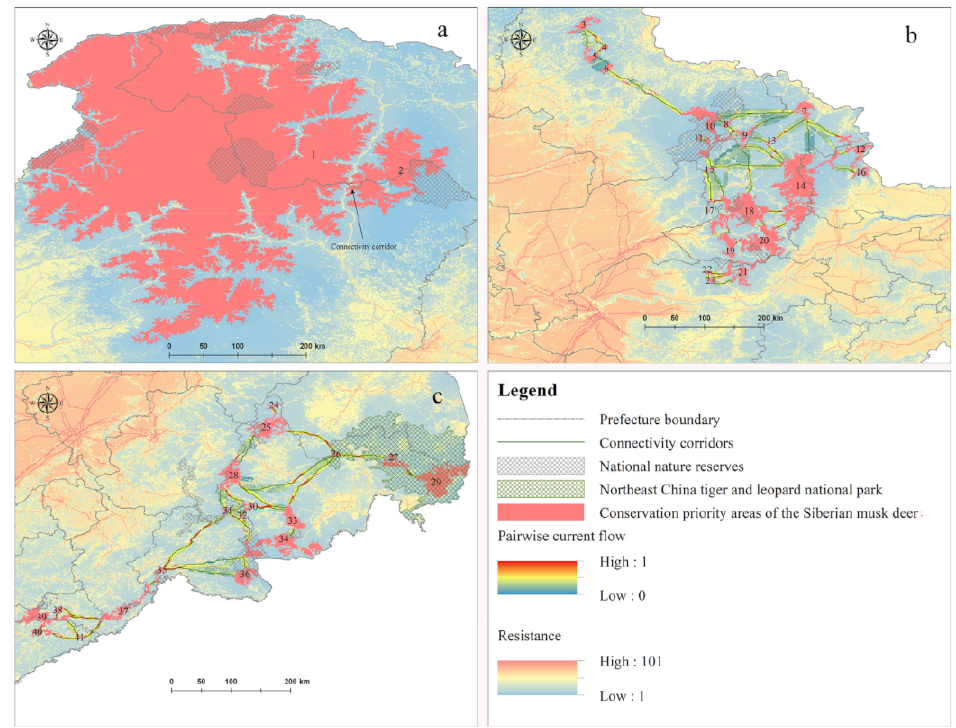
Figure 4. Potential connectivity corridor of M. moschiferus in three biogeographic regions (( a ): Greater Khingan Mountains zone; ( b ): Lesser Khingan Mountains zone; ( c ): Changbai Mountains zone; corridor width: 20